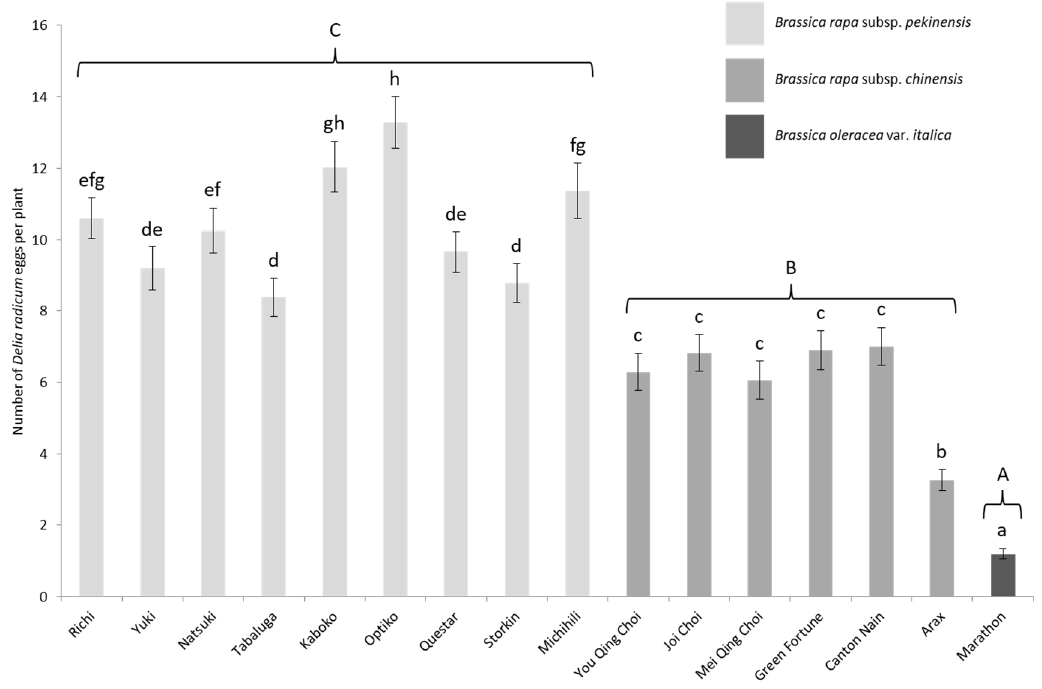
Figure 3. Mean number ( ± S.E.) of D. radicum eggs per plant depending on the cultivar in the field experiment. Di ff erent capitalized letters indicate significant di ff erences between subspecies (GLMM, FDR, p < 0.05) and lowercase letters, significant di ff erences between cultivars (GLMM, FDR, p < 0.05).